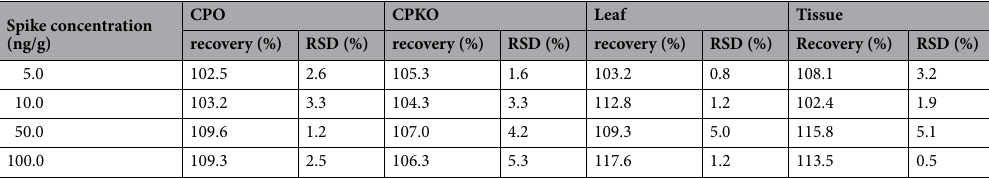
Table 2. Recoveries of hexaconazole from matrix solution of CPO, CPKO, leaf, and tissue of oil palm.